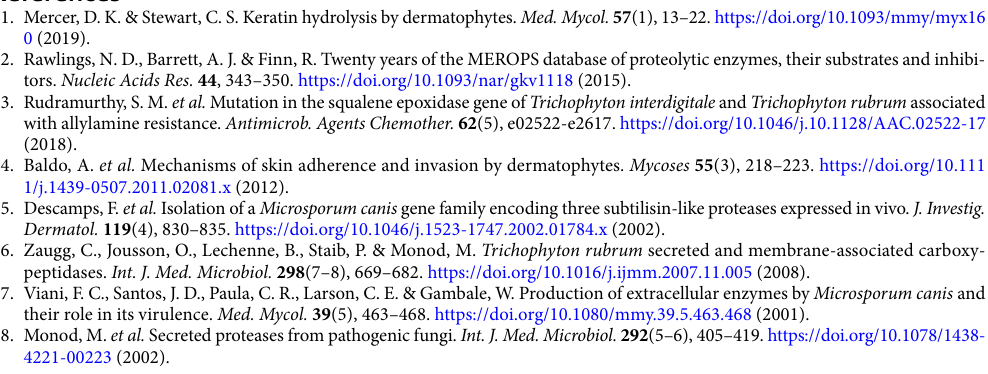
it organizes them into different subgroups. This approach combines the intra-group and intergroup expression variation to a stability index that enables the ranking of genes by expression stability. A low numerical value for the stability index corresponds to a high stability in gene expression 17–20,33,34 .